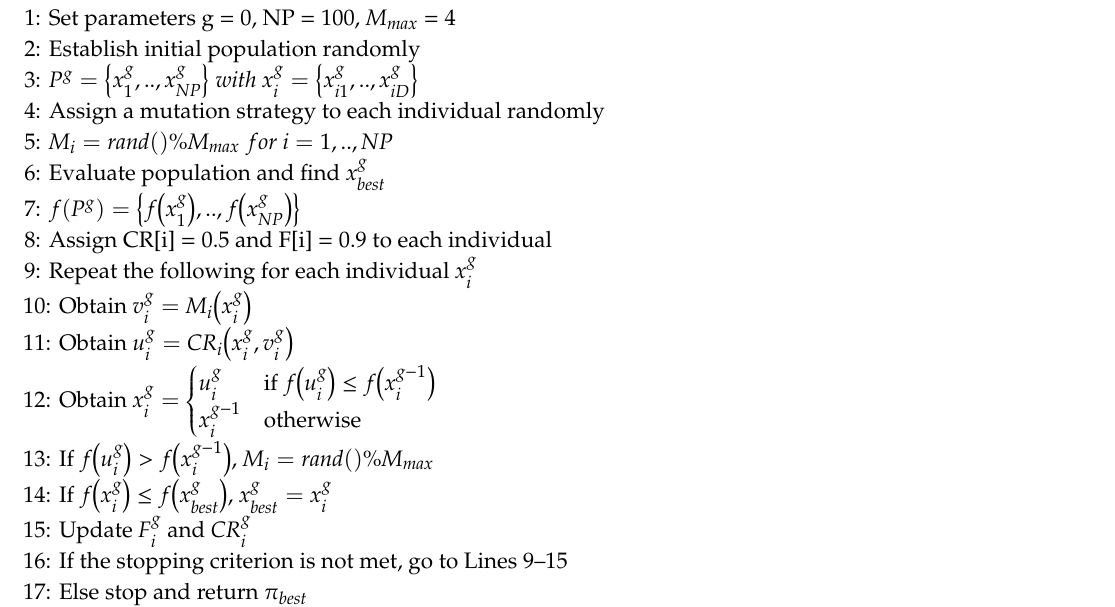
Algorithm 1. The self-adaptive di ff erential evolution algorithm with ensemble of mutation